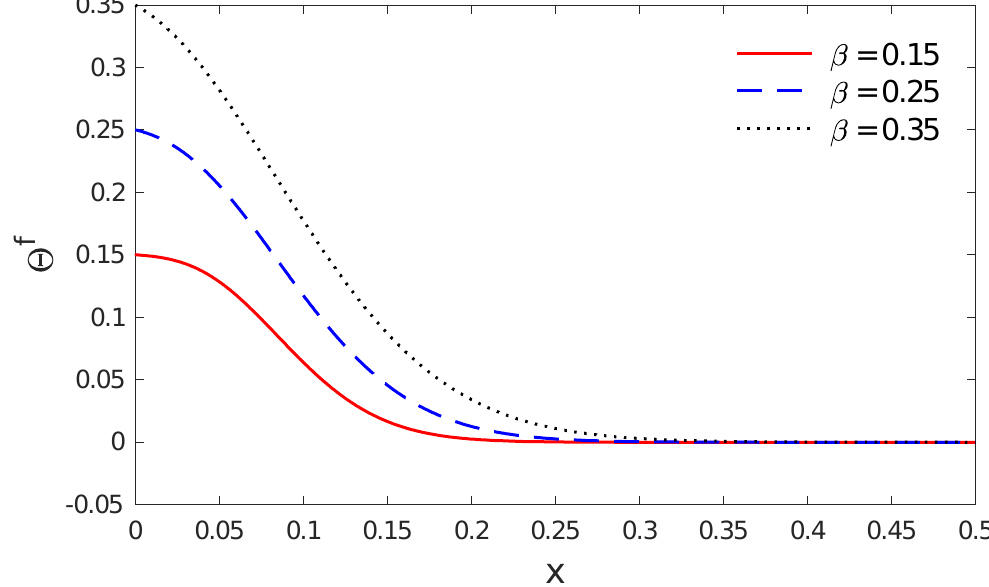
Figure 1. The variations of fluid temperature Θ 𝑓 with respect to 𝑥 for several values of porosity.